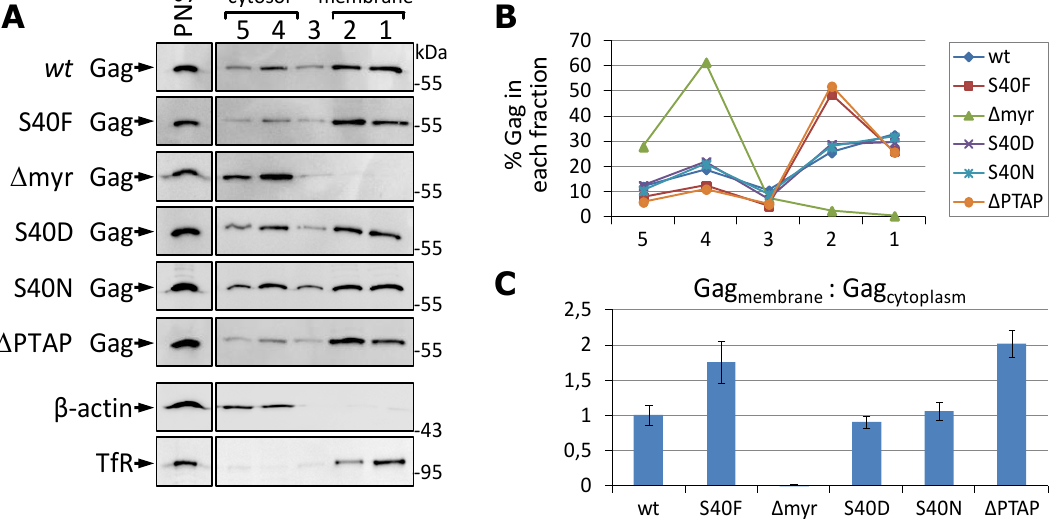
Figure 4. The S40F mutation increases selectively the membrane association of Pr55. ( A ) HeLa cells were transfected with p∆R PR − HIV-1 constructs directing the expression of either wt Gag, the p6 S40F, S40N, S40D or ∆PTAP mutants or the MA G2A